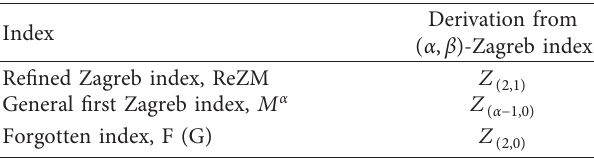
Table 2: Relations of Indices with ( α , β ) -Zagreb